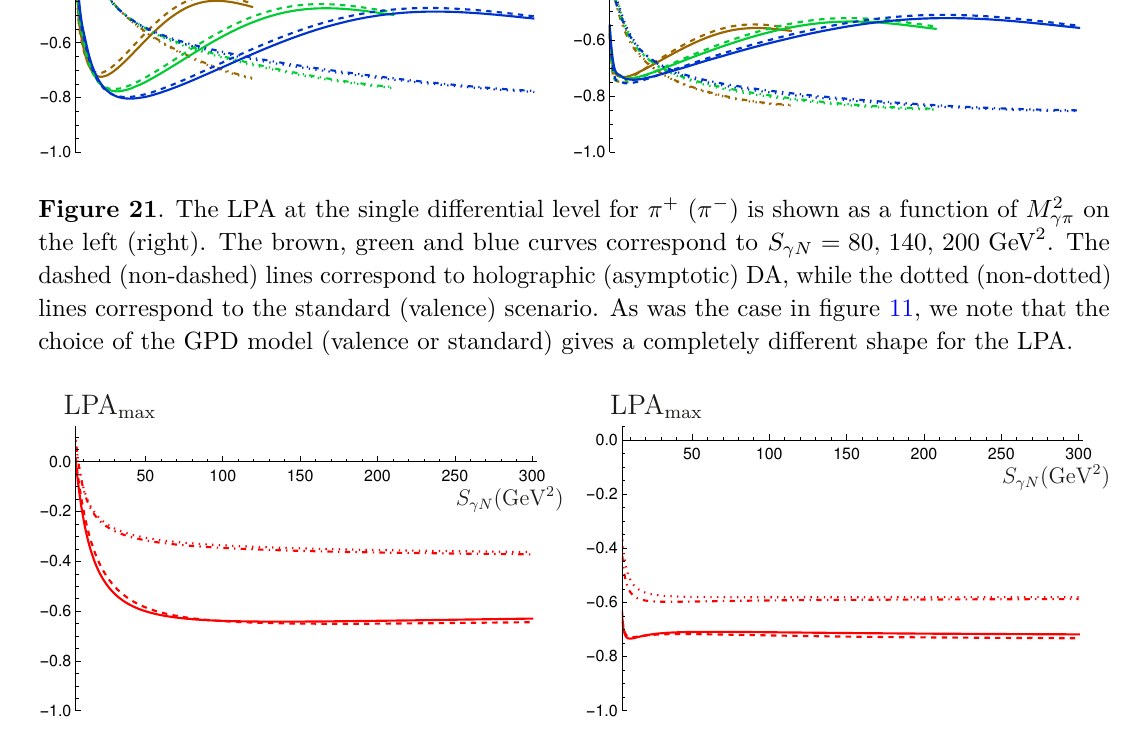
Figure 22 . The LPA integrated over all differential variables for π + ( π − ) is shown on the left (right) as a function of S . The dashed (non-dashed) lines correspond to holographic (asymptotic) γN DA, while the dotted (non-dotted) lines correspond to the standard (valence)